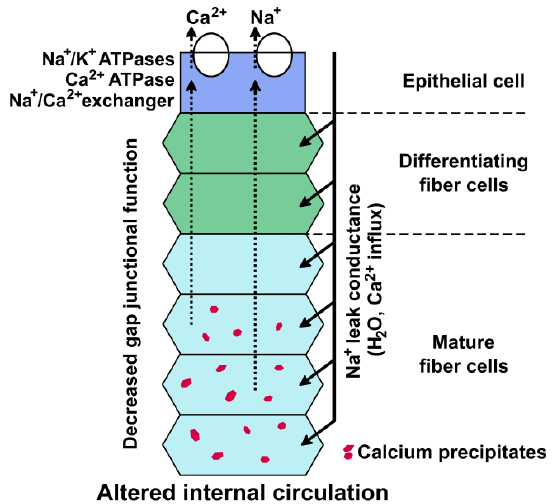
Figure 4. Lens connexin mutants alter the lens circulation. The diagram shows the lens circulation in a cellular column of a homozygous connexin mutant lens to illustrate the effects of the expression of the connexin mutant. The expression of a mutant connexin decreases the gap junction-mediated circulation of ions (dotted lines). An increase in [Na + ] i leads to a decrease in the activity of the Na + /Ca 2+ exchanger. An increase in [Ca 2+ ] i above 1 μM exceeds the buffering capacity, resulting in the formation of Ca 2+ -containing precipitates. Modified from Gao et al. (Figure 8B) [3].